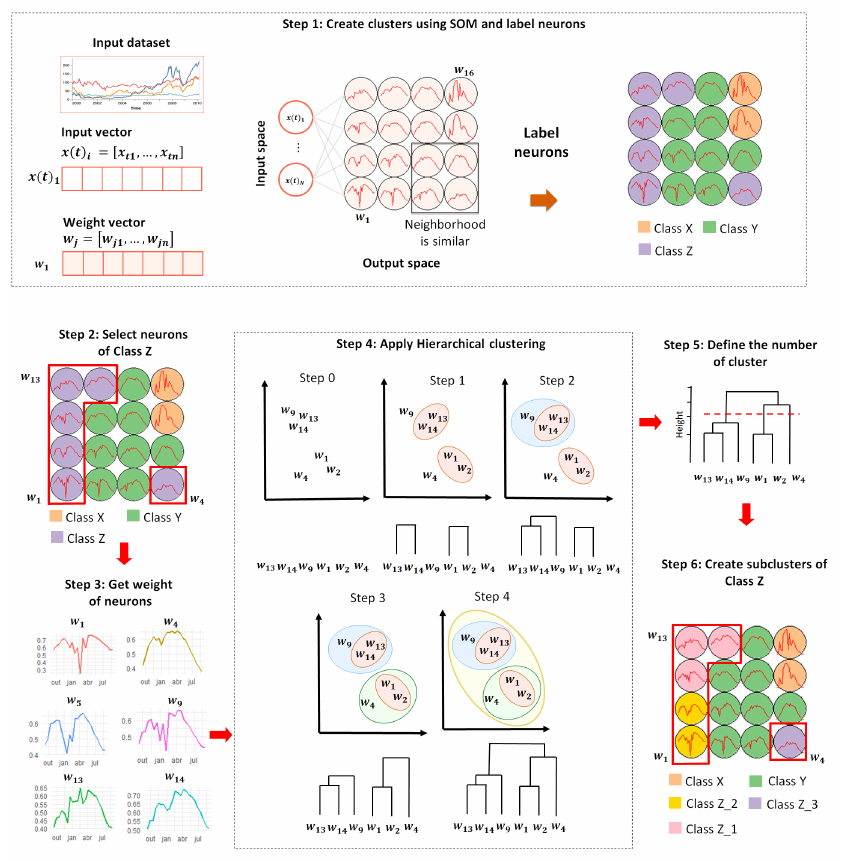
Figure 2. The method for exploratory analysis using time series based on clustering